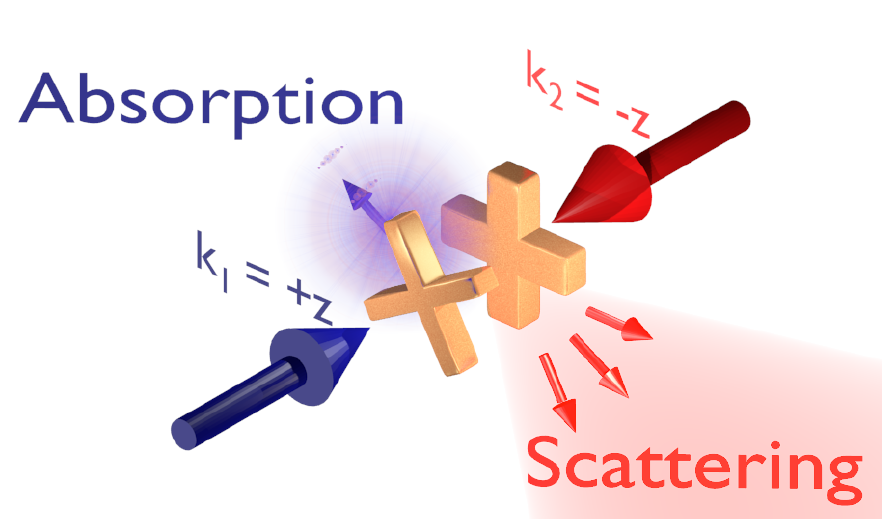
Figure 1. A schematic representation of different optical loss channels: radiative (scattering) and dissipative (absorption). A planewave propagating in one direction will be channeled into far field scattering, while (simultaneously) an identical plane wave propagating in the opposite direction will be channeled into material